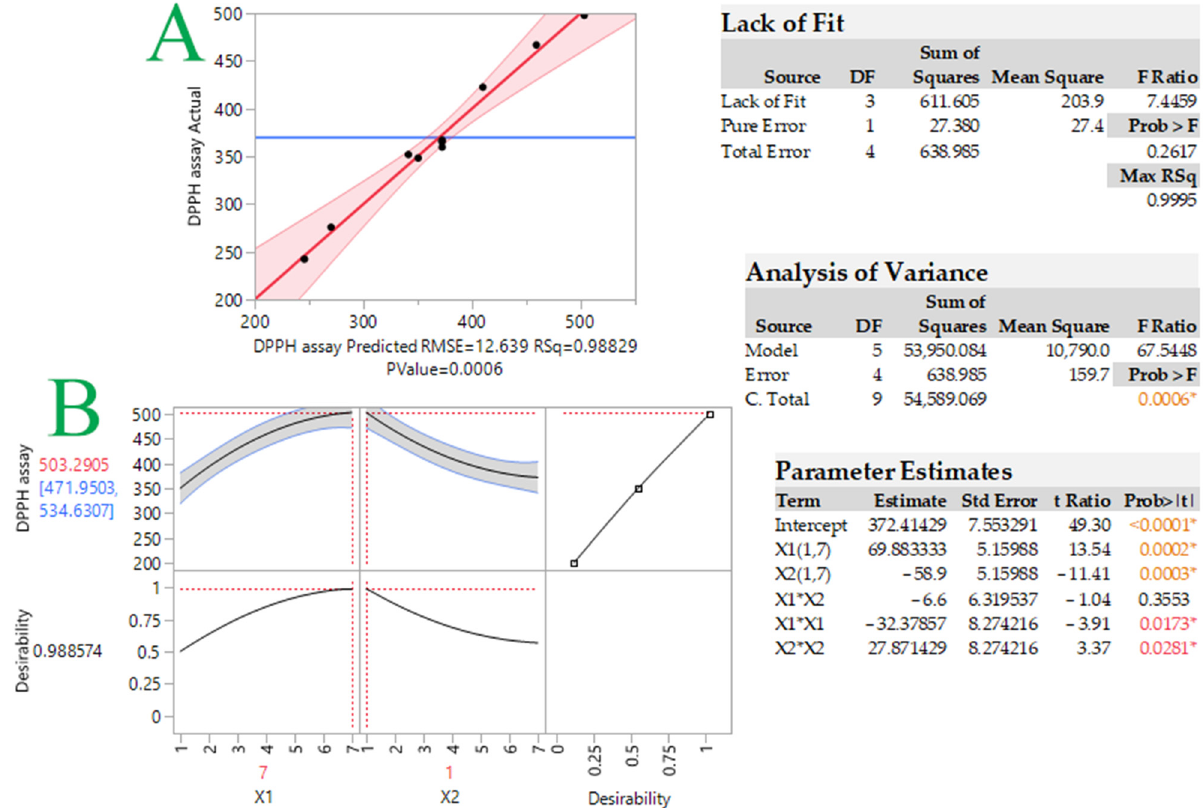
Figure 1. Plot comparing actual vs. predicted values for response (DPPH assay, μ M TEAC) (plot A ) and desirability function (plot B ) for DPPH-optimized radical scavenging activity of tocopherol mixtures. Statistics for evaluation of the model that was developed are provided in the inset tables. Asterisks and colored values indicate statistically significant values.